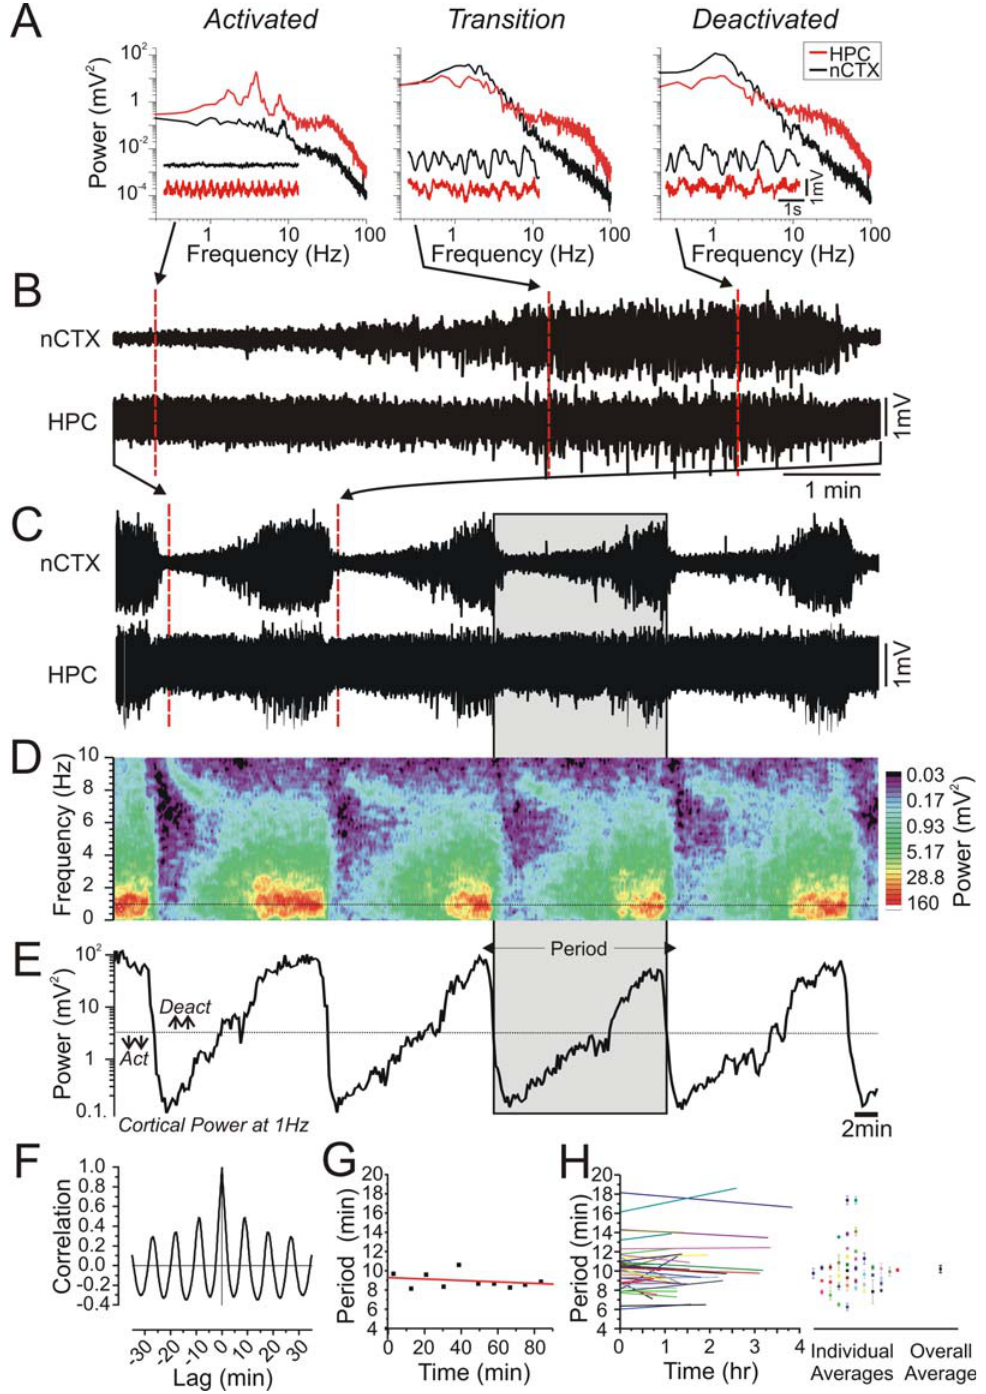
Figure 1. Urethane anaesthetized animals displayed spontaneous and cyclic alternations of brain state. A) Spectra and raw EEG traces of different spontaneous states under urethane. During the activated state, the nCTX showed low voltage fast activity and the HPC showed prominent theta at , 4 Hz. During the transition state, there was an increase in overall power with a shift to lower frequencies at both sites; raw EEG traces showed irregular and moderately high amplitude activity. During the deactivated state, there was an even more prominent shift to low ( , 1 Hz) frequencies with a further increase in overall power and raw EEG traces displaying prominent rhythmic high amplitude slow activity. B) Continuous EEG traces of a spontaneous transition from activated to deactivated patterns. Positions from where the expanded traces in A were taken are shown. The transition between activated and deactivated patterns was marked by a gradual increase in the amplitude of the signals whereas the transition between deactivated and activated patterns was more abrupt. C) , Continuous EEG traces over an even longer time scale demonstrated a regular and cyclic alternation of state as observed by the fluctuations in amplitude. The position from where traces in B were taken are shown. D) A spectrographic representation of the neocortical trace shown in C. The most prominent fluctuation of power was centered at a frequency of circa 1 Hz. E) Plot of power at 1 Hz from the spectrograph in D. The power values showed a cyclic fluctuation in amplitude continuing over the entire time of recording with an average period of , 9 minutes. F) Autocorrelation of power values from the experiment shown in ( E ) that showed a prominent